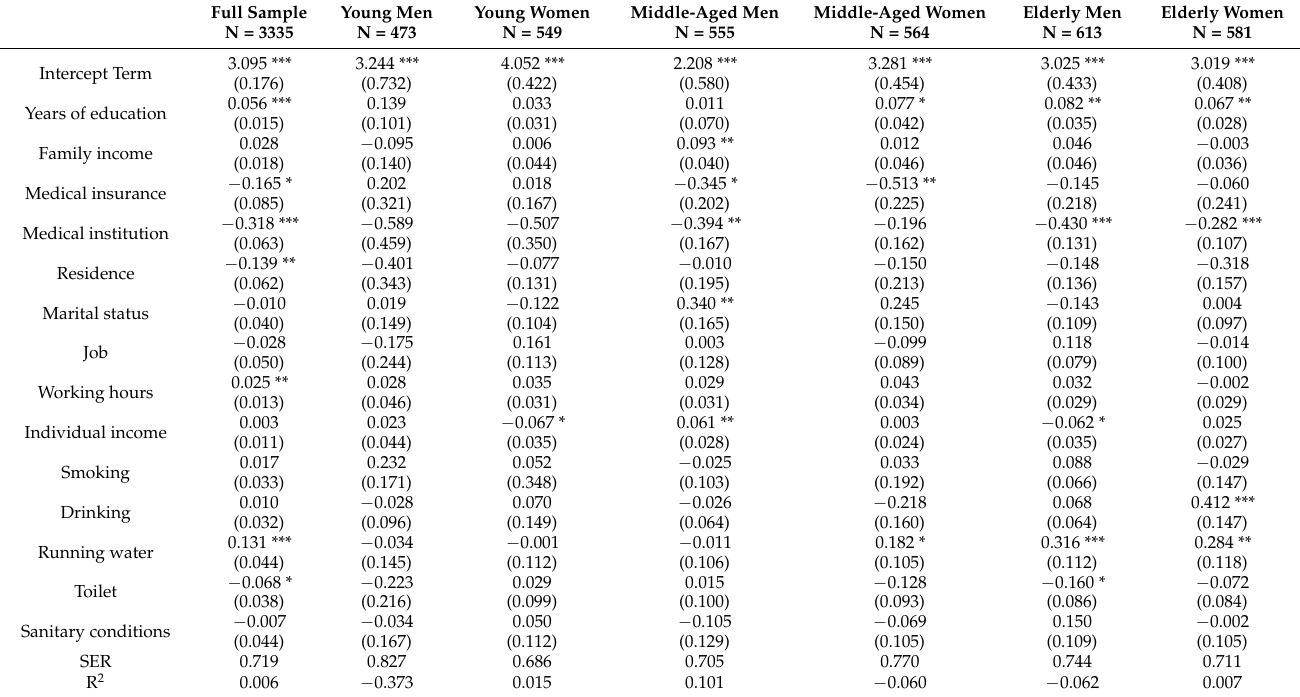
Table A7. Results of two-stage least squares (by age and sex, for physical